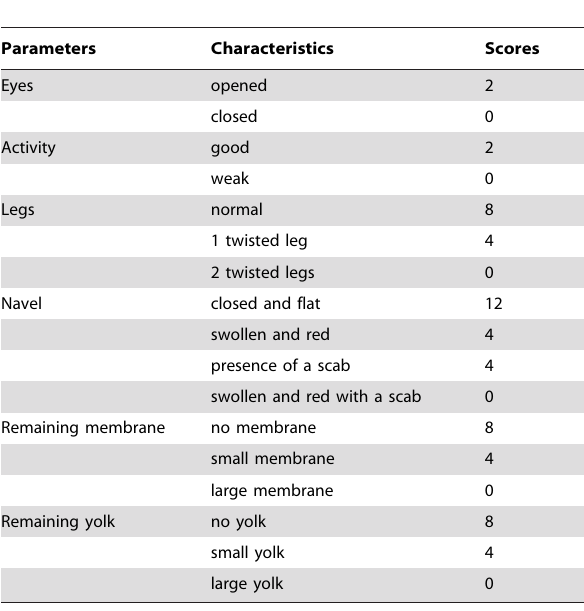
Table 1. Allocation of scores to morphological parameter observations (completely described by Tona et al.